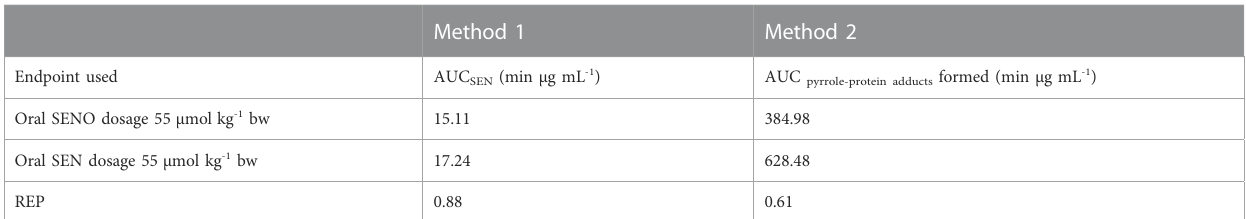
TABLE1 Invivo REPvaluesofSENOrelativetoSENascalculatedbytwomethodsbasedondifferentendpoints(seeFigure1forfurtherdetails). Invivo dataforAUC of SEN and AUC of pyrrole-protein adducts formed are extracted from Yang et al. (Yang et al.,